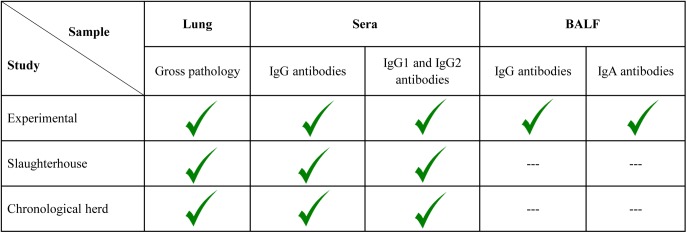
Parameters and samples evaluated within the experimental, slaughterhouse and chronological herd studies.Macroscopic lung lesions were quantified by the European Pharmacopoeia (Ph. Eur., monograph number 04/2013:2448) lung scoring system. All humoral immune parameters were assessed by ELISA technique.